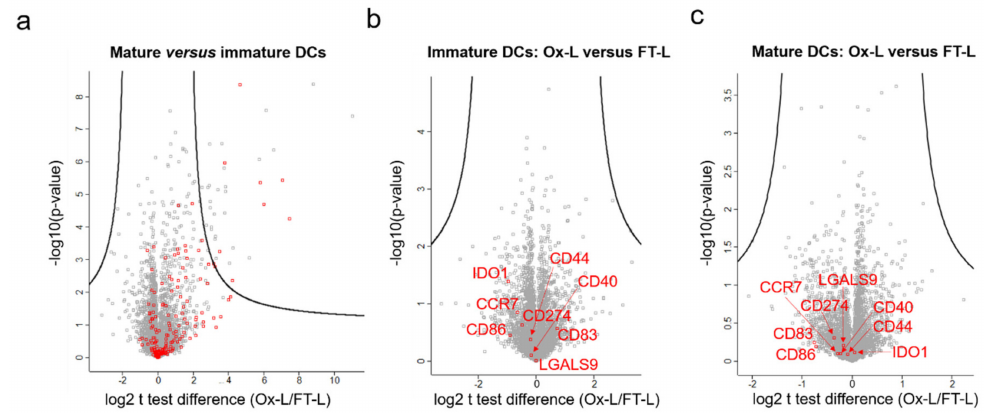
Figure 4. HOCl antigen treatment does not influence DC phenotype and maturation status. Mo-DCs were loaded with Ox-L, FT-L or left unloaded (antigen negative control) for 24 h, then incubated either with LPS and IFN- (mature DCs) or with no supplements (immature DCs). Cells were then extensively washed, trypsinized and analyzed through LC-MS / MS. ( a ) Volcano plot representation of t test analysis comparing protein intensities in mature versus immature mo-DCs; each point represent one protein plotted by log2 fold change versus minus logarithm of the q -value (Benjamini-Hochberg corrected p -value), with a cuto ff value of 0.05; in red genes belonging to the immunity class, expected to be upregulated upon DC maturation (keywords classification). ( b ) Same as (a) comparing immature DCs loaded with Ox-L versus FT-L, in red genes encoding for main surface proteins with stimulatory or inhibitory e ff ects on T cell activation. ( c ) Same as ( a ) comparing mature DCs loaded with Ox-L versus FT-L, in red genes encoding for main surface proteins with stimulatory or inihibitory e ff ects on T cell